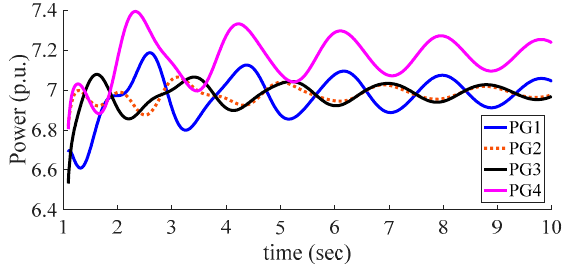
Figure 7. Kundur’s two-area test system [1].